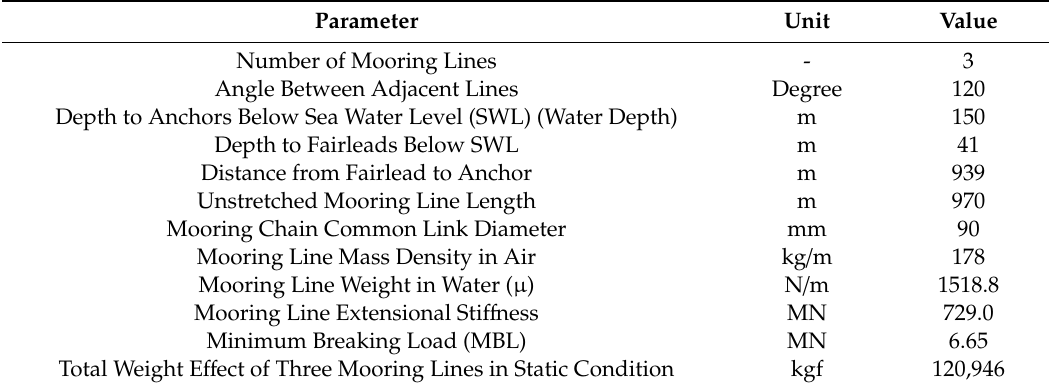
Table 2. Mooring system properties.